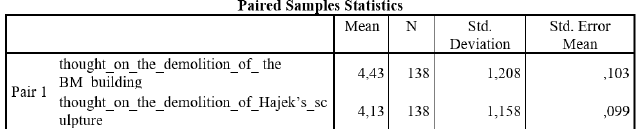
Table 3. Paired Samples Statistics among the participants thought on the demolitions of the Bank of Municipalities